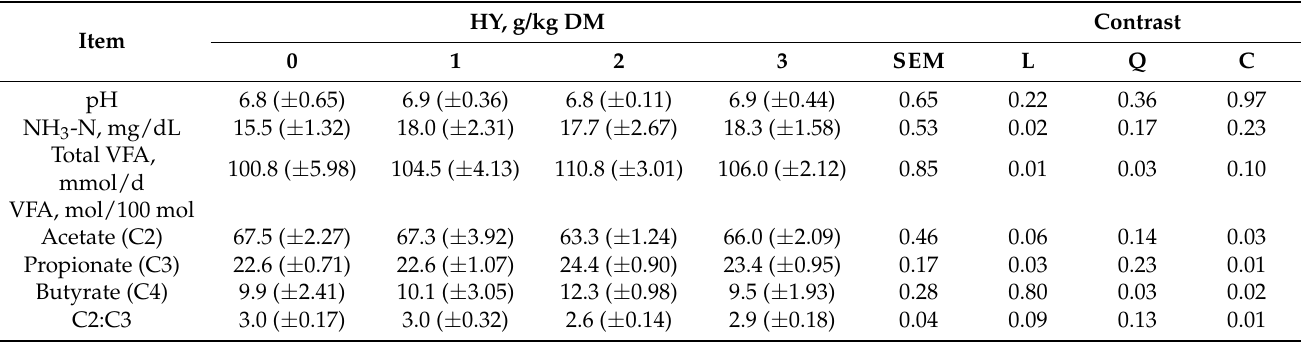
Table 4. Effect of HY supplementation on rumen fermentation in growing beef cattle.